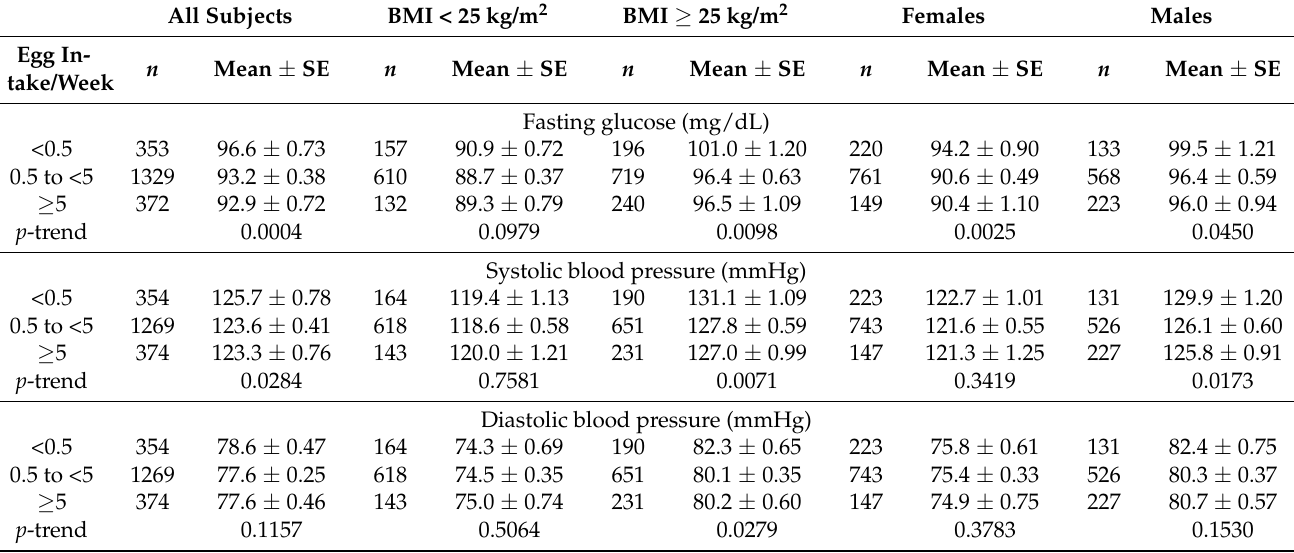
Table 2. Effects of egg intake on fasting glucose and blood pressure after four years of follow-up, stratifying by baseline BMI and by sex 1